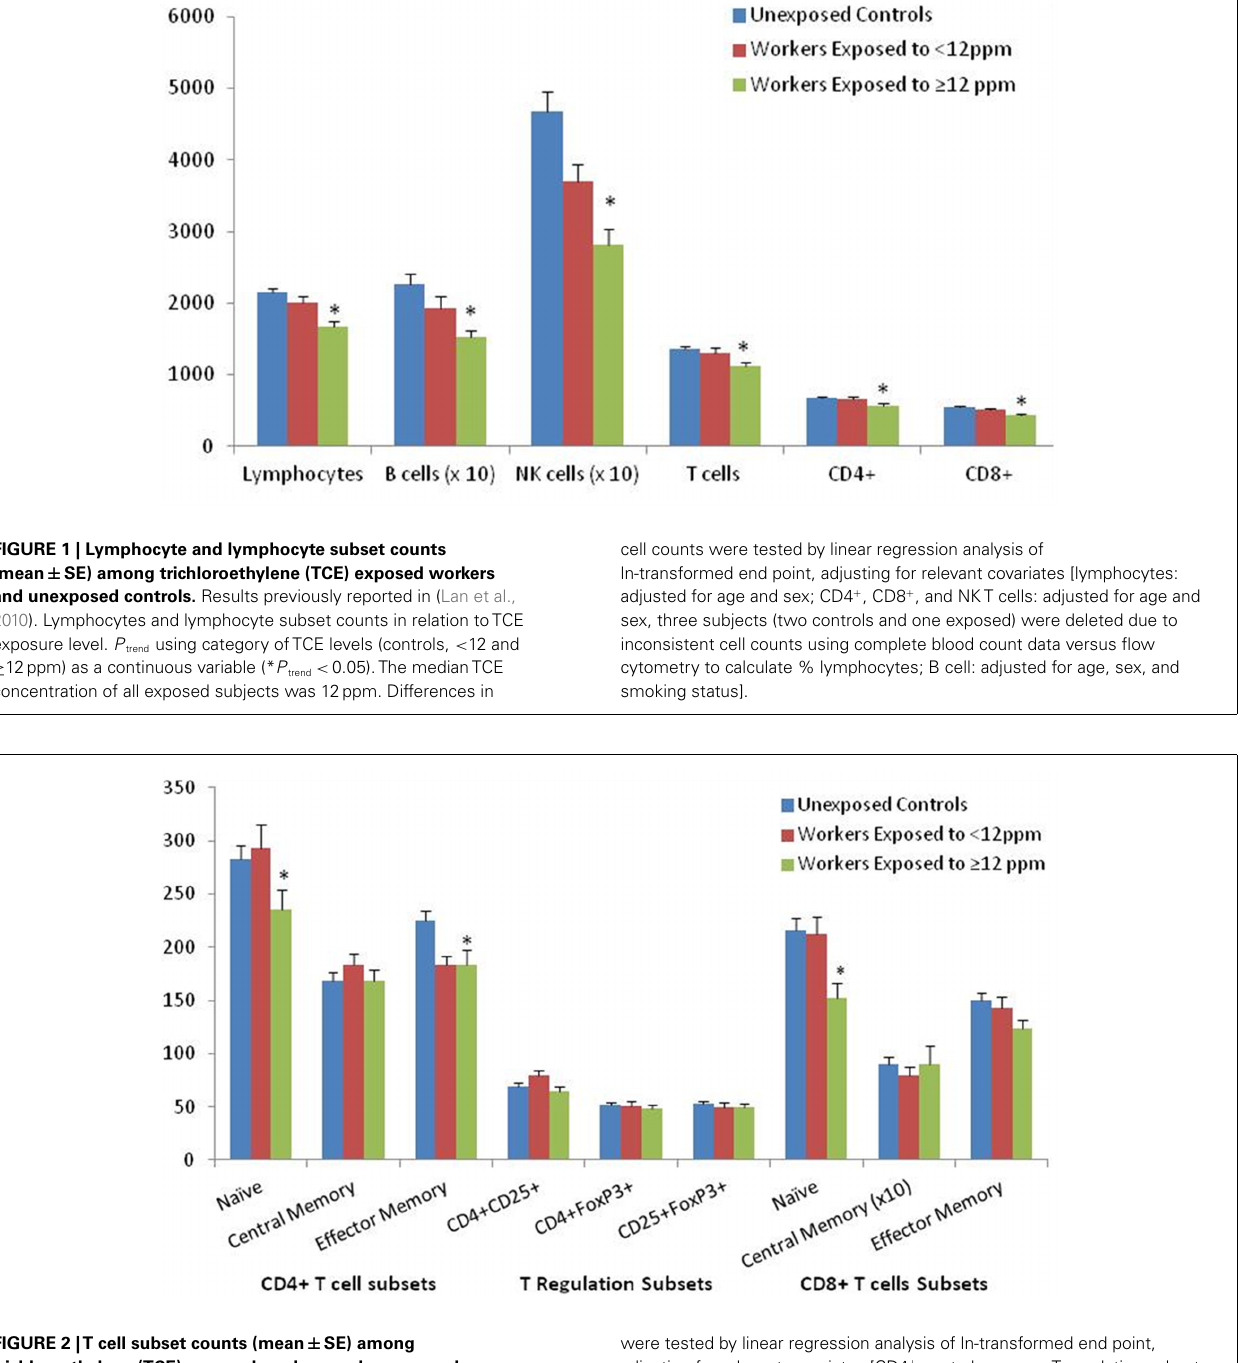
FIGURE 2 |T cell subset counts (mean ± SE) among were tested by linear regression analysis of ln-transformed end point, trichloroethylene (TCE) exposed workers and unexposed adjusting for relevant covariates [CD4 + central memory,T regulation subsets, controls. T cell lymphocyte subset counts in relation toTCE CD8 + naïve, CD8 + central memory cells: adjusted for age, sex; CD4 + naïve exposure level. P trend using category ofTCE levels (controls, < 12 and cells: adjusted for age, sex, infection; CD4 + effector memory: adjusted for ≥ 12ppm) as a continuous variable (* P < 0.05).The medianTCE age, sex, smoking status; CD8 + effector memory: adjusted for age, sex, BMI]; trend concentration of all exposed subjects was 12ppm. Differences in cell counts * P trend <